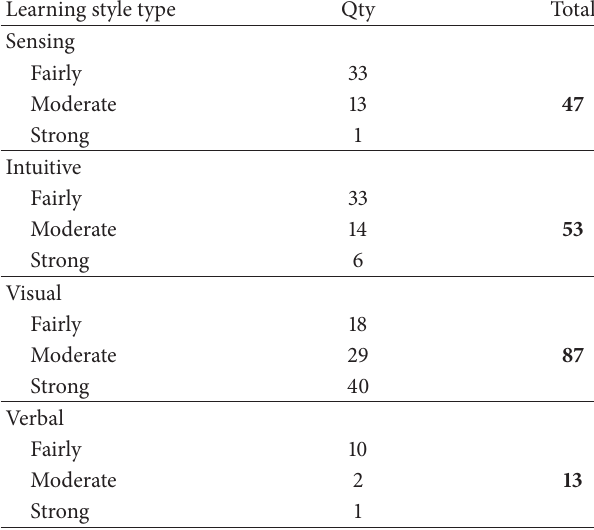
Table 6: The learning style